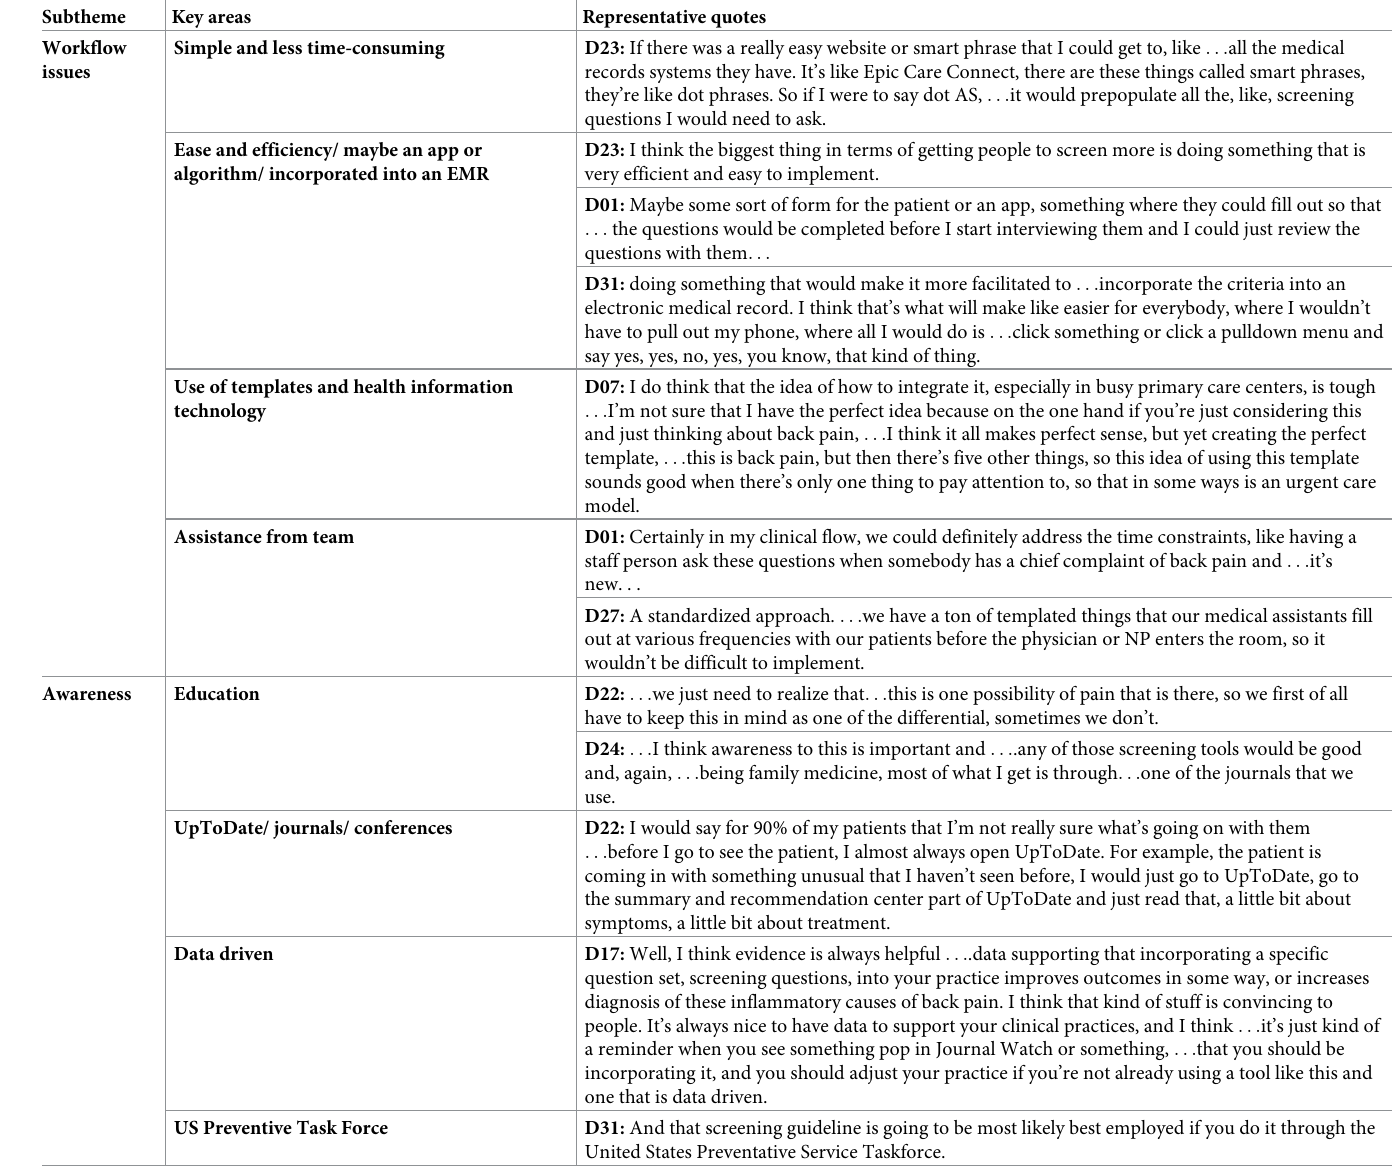
Table 6. Primary care physician perceptions of perceived facilitators to implement the screening tool for axial spondyloarthritis. Subtheme Key